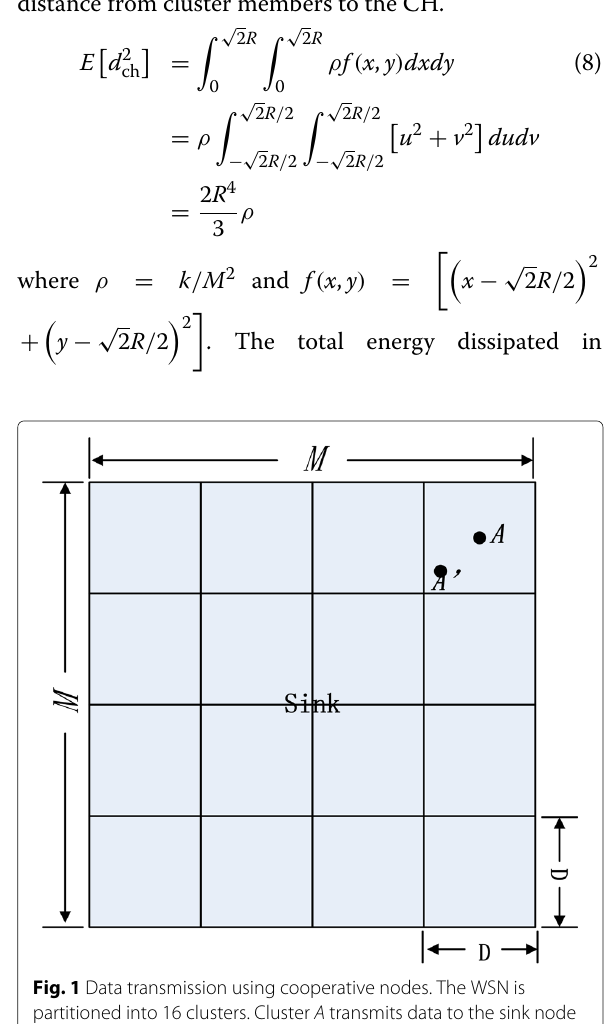
Fig. 1 Data transmission using cooperative nodes. The WSN is partitioned into 16 clusters. Cluster A transmits data to the sink node through cooperative node A